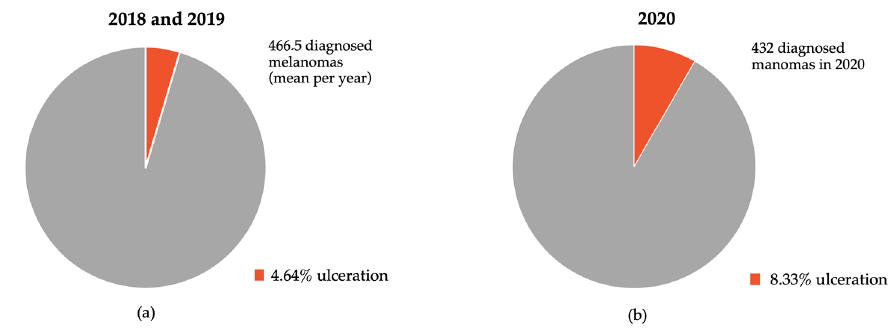
Figure 4. Percentage of ulcerated melanomas diagnosed in ( a ) 2018/2019 and ( b ) 2020 depicted in red; 4.9%, 4.3%, and 8.3% of all melanomas diagnosed in 2018, 2019 and 2020 were ulcerated ( p = 0.043 for 2018 vs. 2020, p = 0.012 for 2019 vs. 2020).